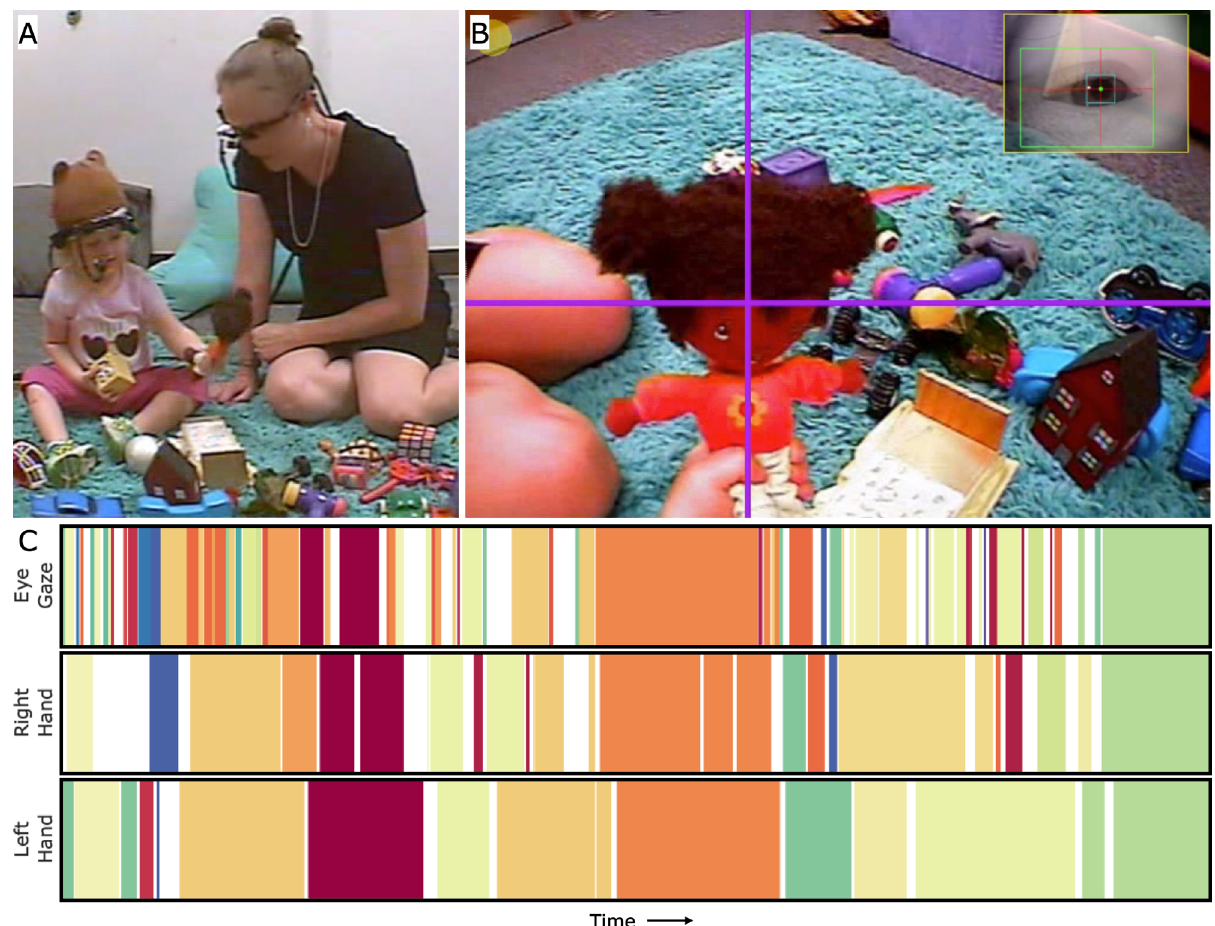
Figure 1. Experimental Set-Up and Data Processing. ( A ) Each dyad member wore a head-mounted eye tracker. Dyad members were seated next to each other and the toys were spread between them to play with following eye-tracker set-up. ( B ) The eye-tracker contains a small infrared camera that recorded each dyad member’s eye movements and a scene camera that recorded the visual scene in front of the participant. Gaze location is indicated with a purple cross-hair. ( C ) The child’s moment-to-moment gaze was manually coded by trained experimenters to indicate which toy they were looking at over the course of the play session. A time-series of visual fixation is shown, where each unique color represents one of the toys. Trained experimenters also indicated which toy was being touched by each hand over the course of the play